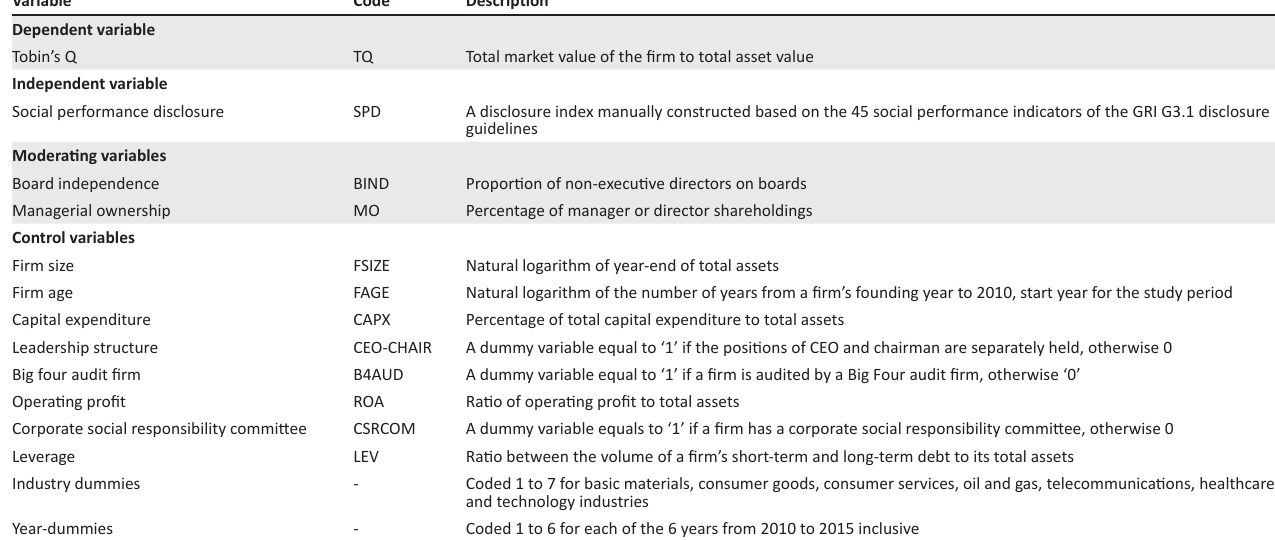
TABLE 1: Variable description. Variable Code